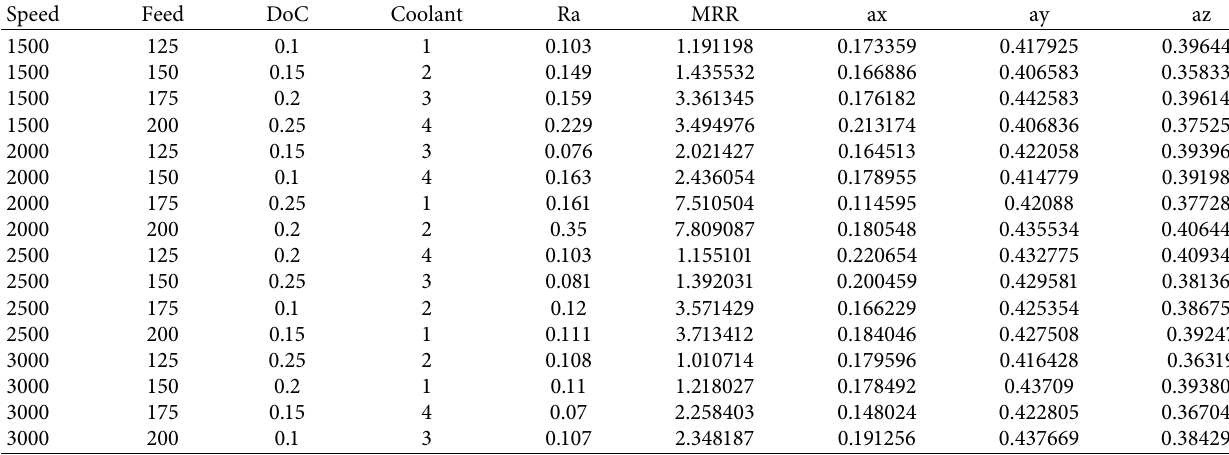
Table 3: Surface roughness, spindle vibration, and MRR for palm oil.